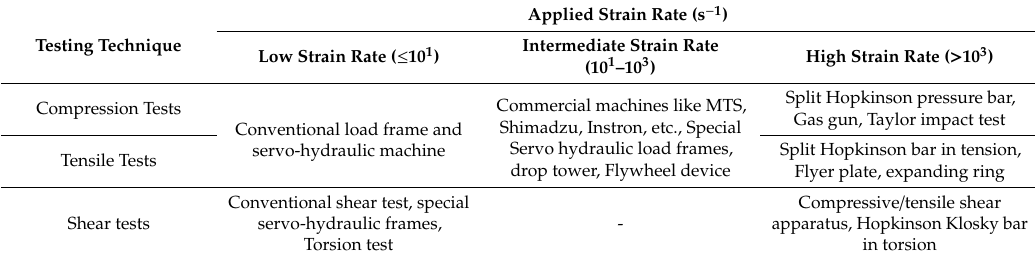
Table 2. Characterization of the machines based on the strain rate and type of